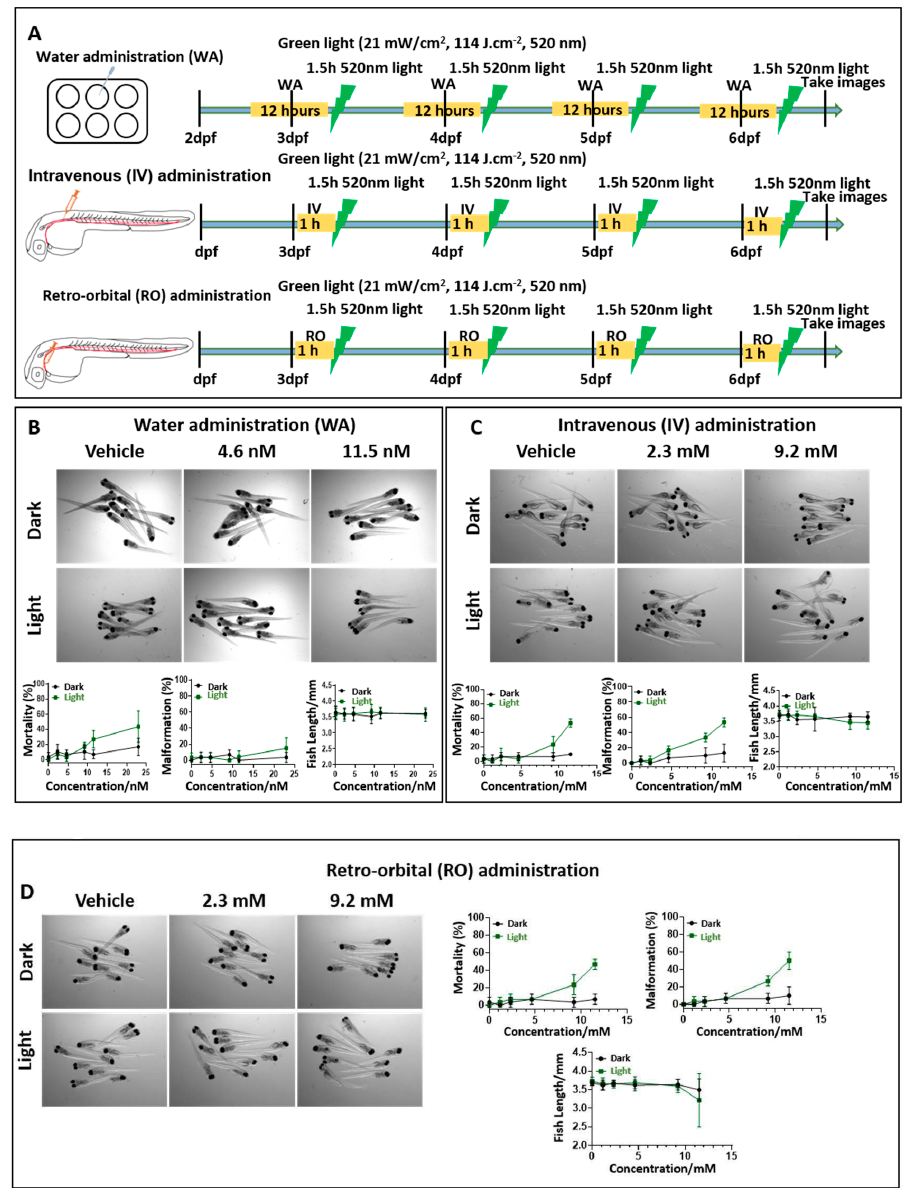
Figure 5. The maximum tolerated dose of TLD1433 in wild type zebrafish embryos administered through three di ff erent routes. ( A ) Schedule of TLD1433 treatment in wild type zebrafish. WA: TLD1433 (2.3 nM, 4.6 nM, 9.2 nM, 11.5 nM, 23 nM) were added to the water containing 10 embryos per well at 2.5, 3.5, 4.5, 5.5 dpf, for 12 h (yellow box). After these treatments, the drug was removed and replaced by egg water followed by 90 min green light irradiation (21 mW/cm 2 , 114J.cm − 2 , 520 nm), depicted as a green lightning bolt. IV or RO: 1 nL of TLD1433 (1.15 mM, 2.3 mM, 4.6 mM, 9.2 mM, 11.5 mM) were injected into the embryos at 3 dpf to 6 dpf every morning, followed by 60 min drug-to-light interval (yellow box) and 90 min green light irradiation (21 mW/cm 2 , 114 J.cm − 2 , 520 nm), depicted as a green lightning bolt. ( B ) WA, ( C ) IV, ( D ) RO. ( B – D ) Images were made of irradiated (light) and non-irradiated (dark) embryos ( n = 30) at 6dpf and the percentages of mortality, malformation and fish length were calculated (shown as means ± SD from three independent experiments). Representative images of embryos under dark and light conditions are shown.